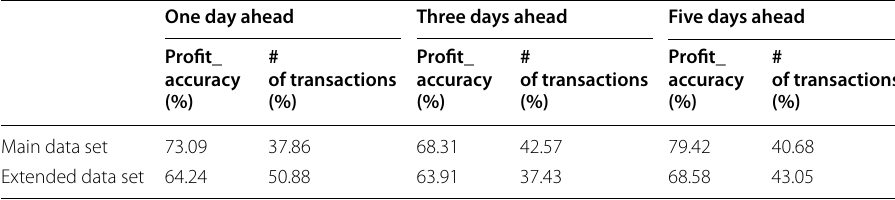
Table 21 Performance comparison of hybrid model One day